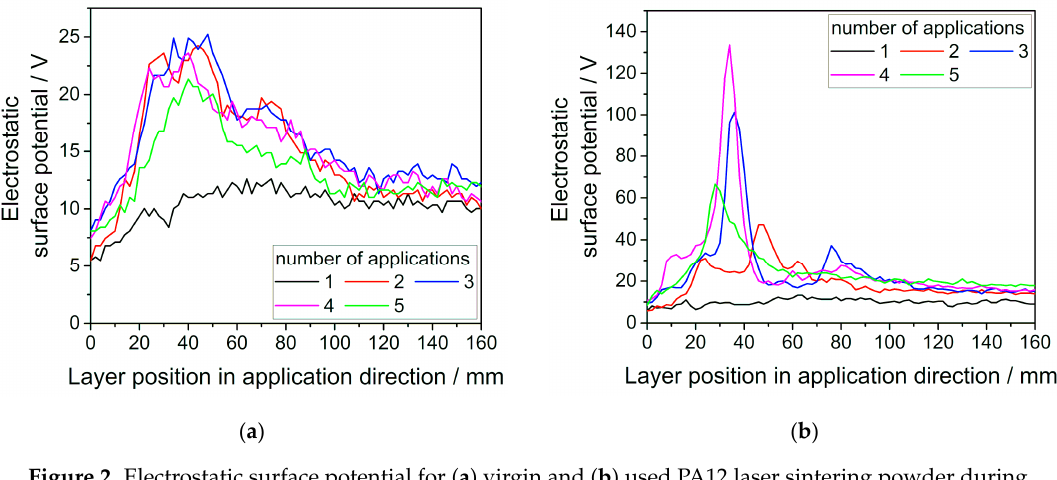
Figure 2. Electrostatic surface potential for ( a ) virgin and ( b ) used PA12 laser sintering powder during layer deposition for repeated application of the same powder sample with a velocity of 10 mm/s. Measurements have been performed at 30% relative humidity.